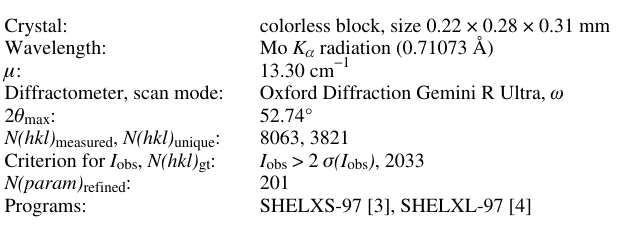
Table 1. Data collection and handling.